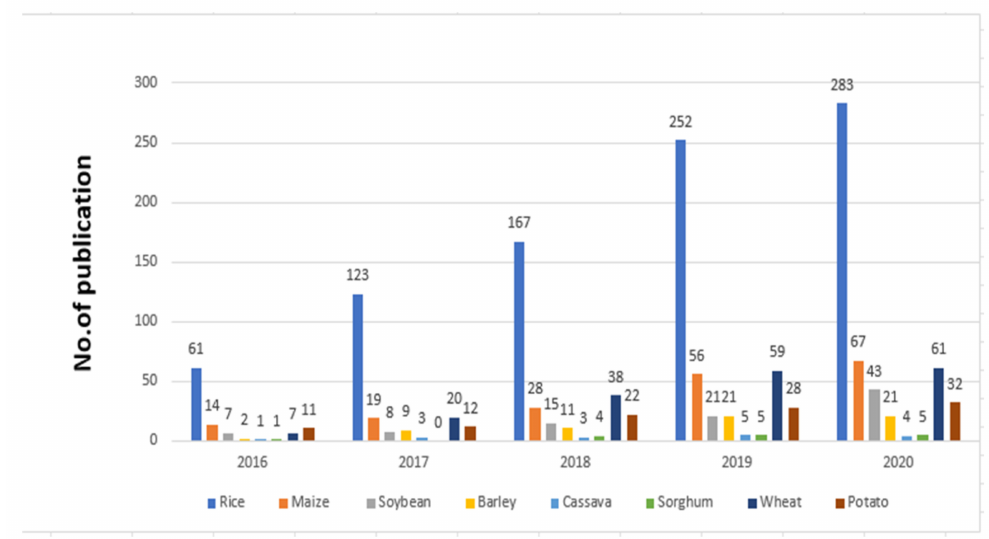
Figure 2. Publications using CRISPR/Cas9 for improving rice and other crops from 2016 to